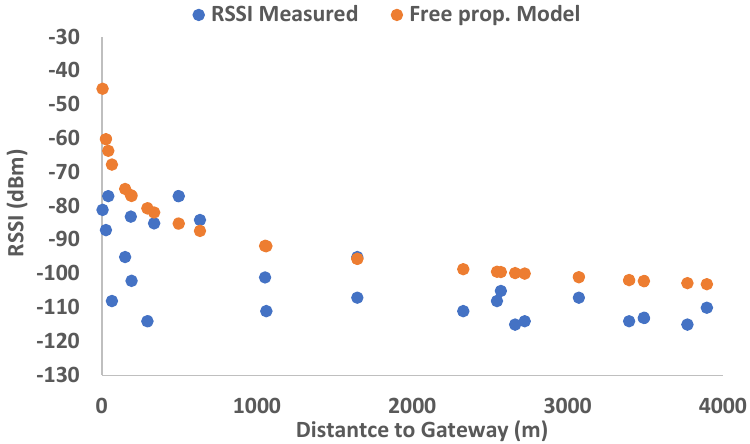
Figure 18. Results of RSSI as a function of the distance.